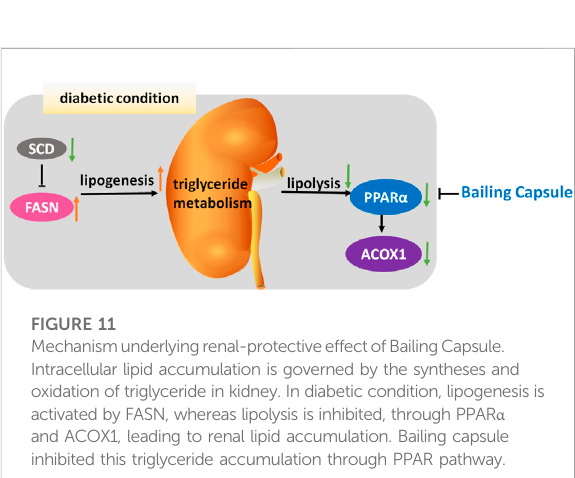
FIGURE 11 Mechanismunderlyingrenal-protectiveeffectofBailingCapsule. Intracellular lipid accumulation is governed by the syntheses and oxidation of triglyceride in kidney. In diabetic condition, lipogenesis is activated by FASN, whereas lipolysis is inhibited, through PPAR α and ACOX1, leading to renal lipid accumulation. Bailing capsule inhibited this triglyceride accumulation through PPAR pathway.